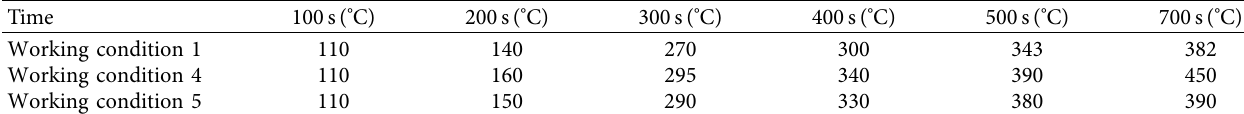
Table 6: Comparison of smoke layer temperatures under working conditions 1, 4, and 5.